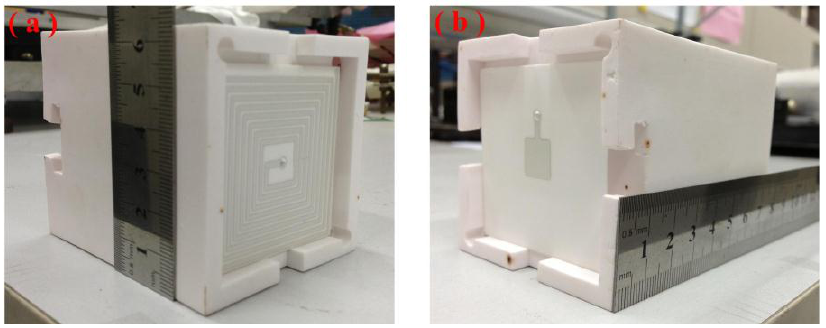
Figure 6. Image of the ( a ) inductance and ( b ) capacitance of the sensor sample.